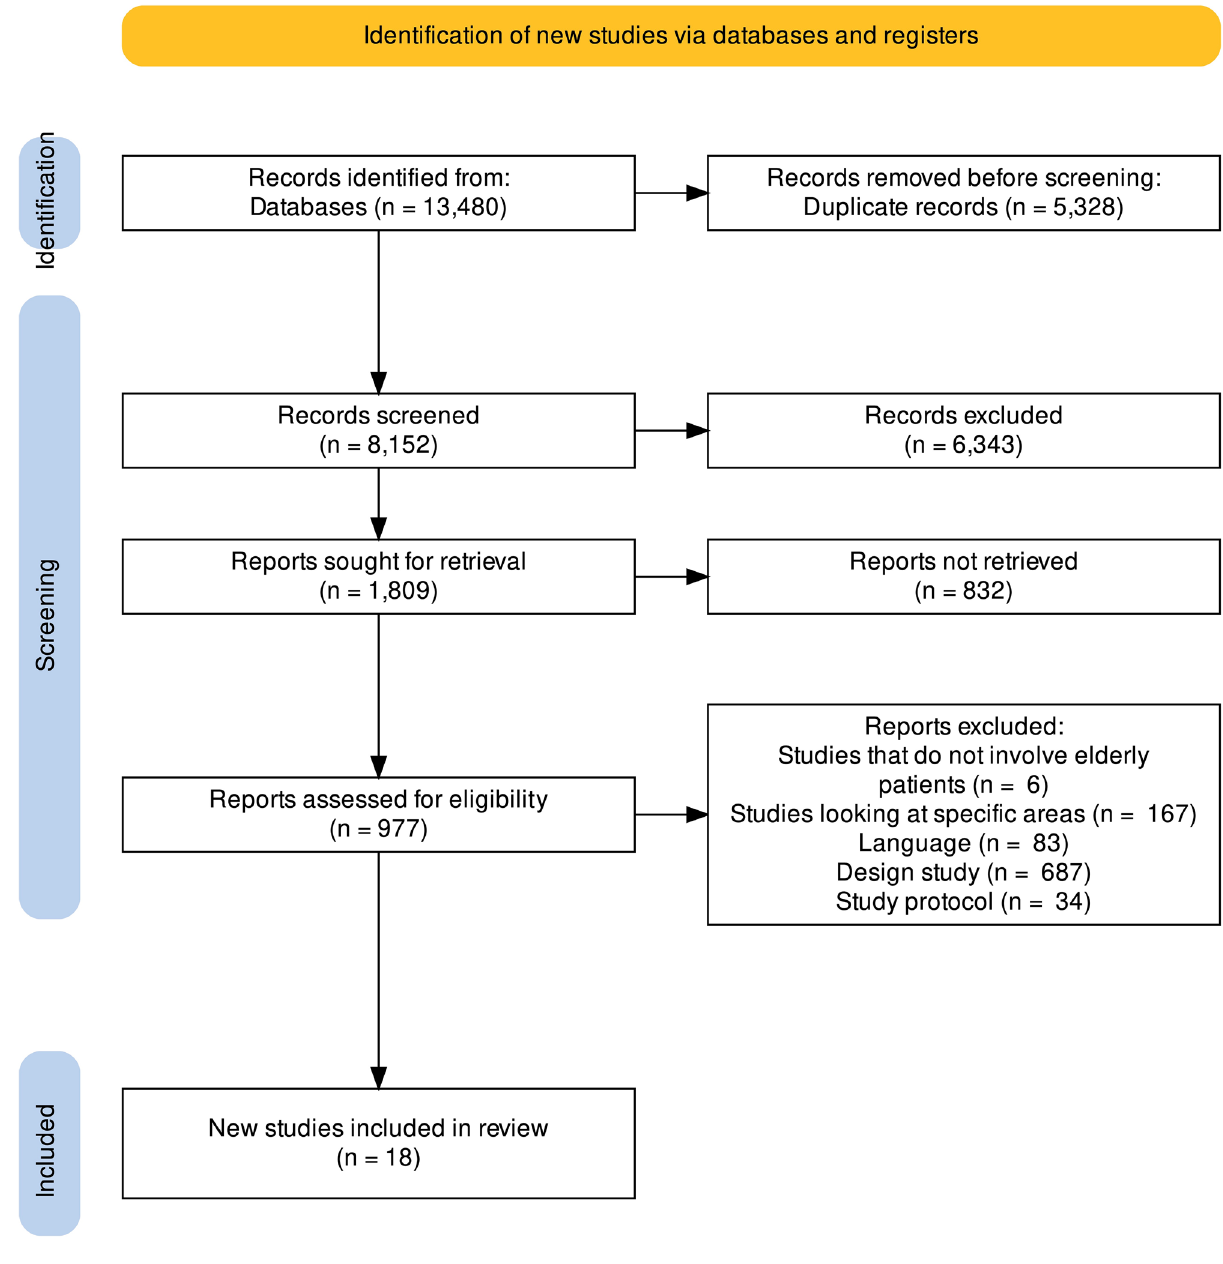
Figure 1. Flow diagram for study